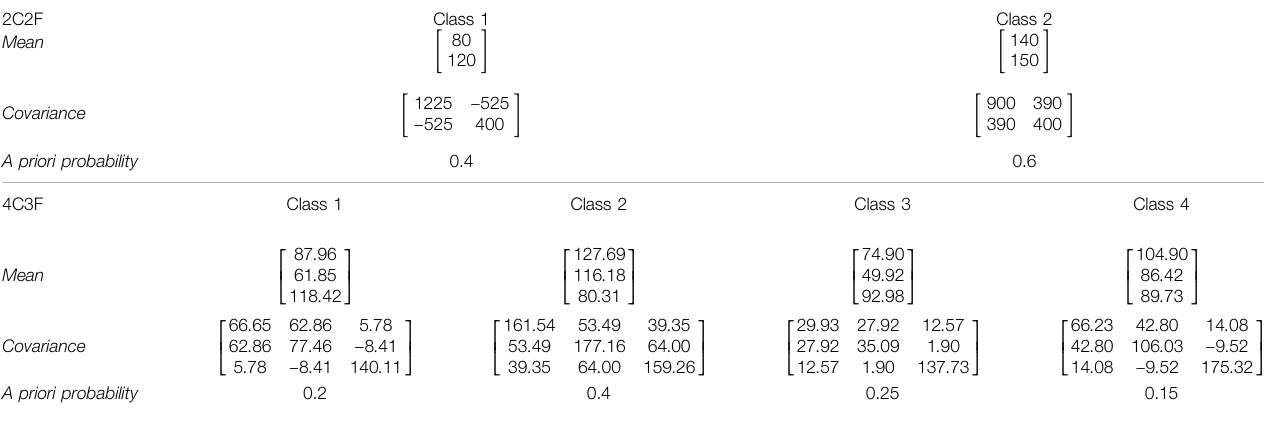
TABLE4| Parametersofthemultivariate Gaussiandistributionsofindividualclassesinthetwo-class,two-feature(2C2F)caseandthefour-class,three-feature(4C3F)case. 2C2F